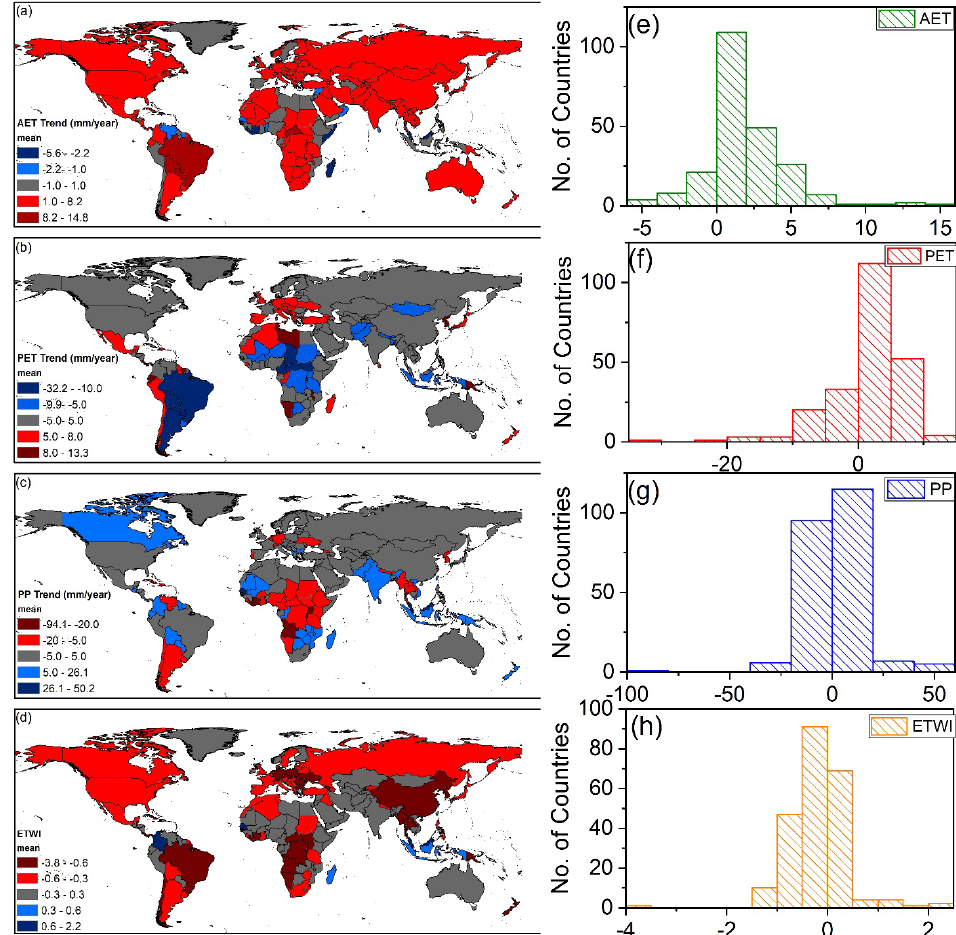
Figure 8. Country-based trend-analysis of ( a ) AET, ( b ) PET, ( c ) PP, and ( d ) ETWI. The panels on the right side show histograms of annual trends in ( e ) AET, ( f ) PET, ( g ) PP, and ( h ) ETWI derived from the countries included in the analysis.